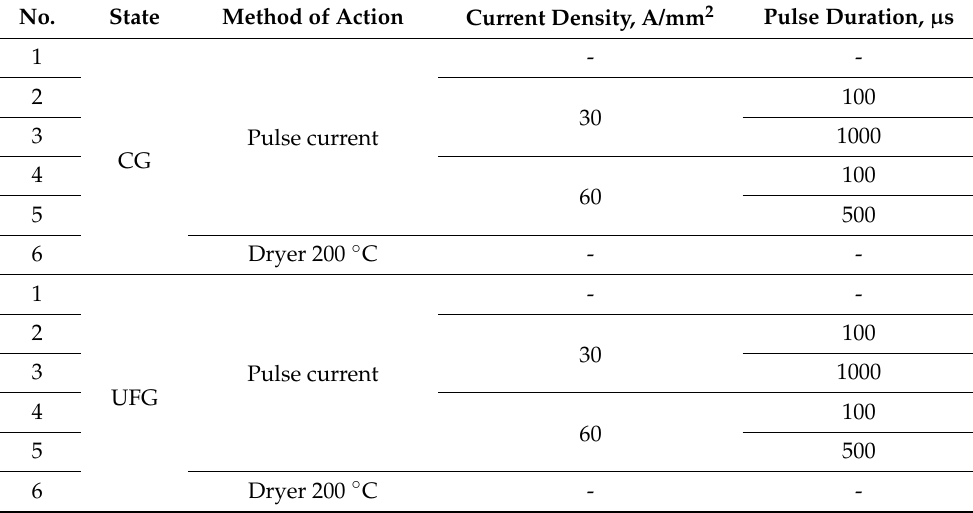
Figure 2. Shape and dimensions of tensile specimens. Table 2. Experimental modes for CG and UFG Table 2. Experimental modes for CG and UFG Ti.